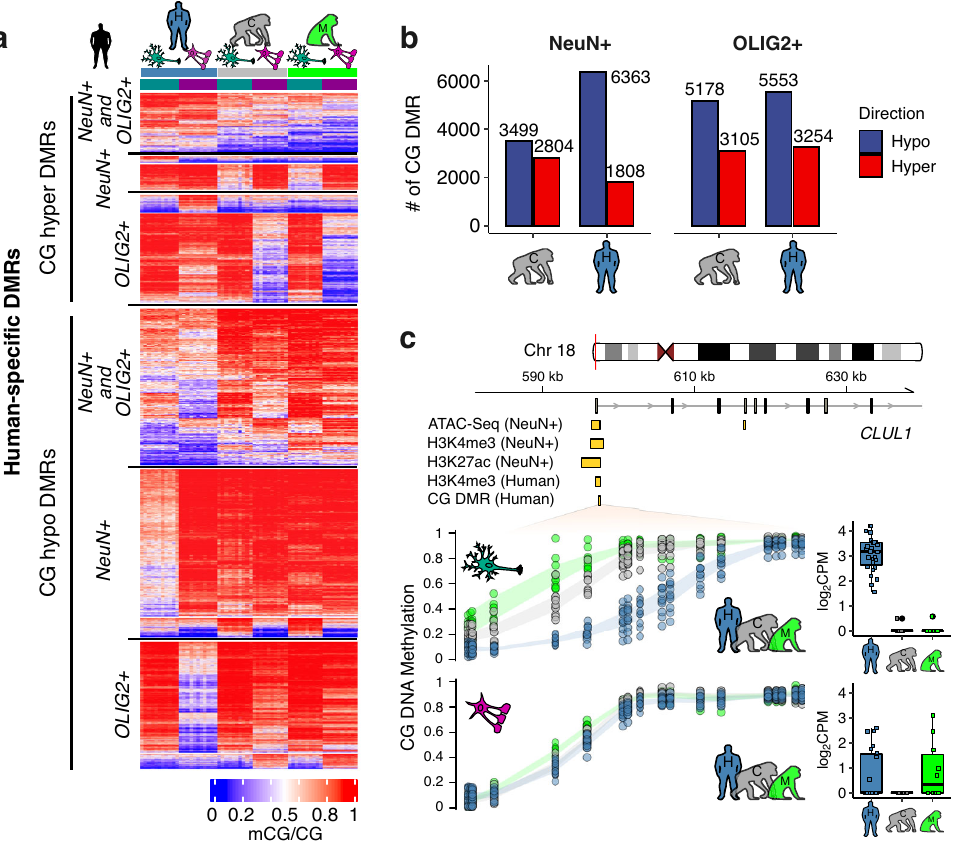
Fig. 2 Evolutionary changes in CG methylation. a Heatmap representation of mean DNA methylation of all 23,703 human DMRs in the three species illustrates dramatic reduction of CG methylation in human prefrontal cortex, especially in neurons. b Numbers of DMRs in NeuN + and OLIG2 + cells in human and chimpanzee frontal cortex. c An example of the relationship between human neuron-hypo CG DMR and other epigenetic marks in the CLUL1 locus, a gene widely expressed in the brain. This DMR overlaps with multiple other epigenetic marks of active chromatin in the human brain, including neuron-speci fi c ATAC-Seq peak, neuron-speci fi c H3K4me3 peak, neuron-speci fi c H3K27ac peak. This DMR also overlaps with a human-speci fi c brain H3K4me3 peak compared to chimpanzee and macaque. Box represents a range from the fi rst quartile to the third quartile. The line in the box indicates the median value. The minima and maxima are within 1.5 times the distance between the fi rst and third quartiles from box. Source data are provided as a Source Data fi le. Cell-type images were color modi fi ed from the original image, which was created by Akiyao and available at the Wikimedia